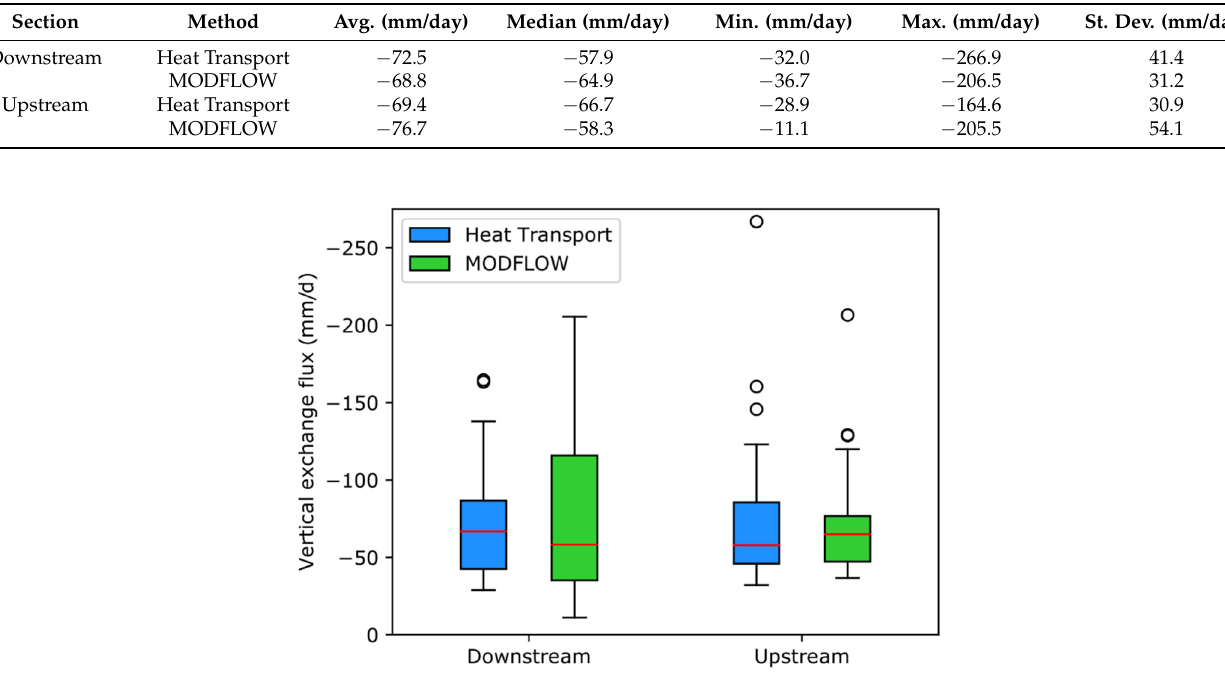
Figure 11. Boxplots of vertical fluxes simulated with heat transport modelling (blue) and groundwater modelling (green) for both the downstream and upstream sections.